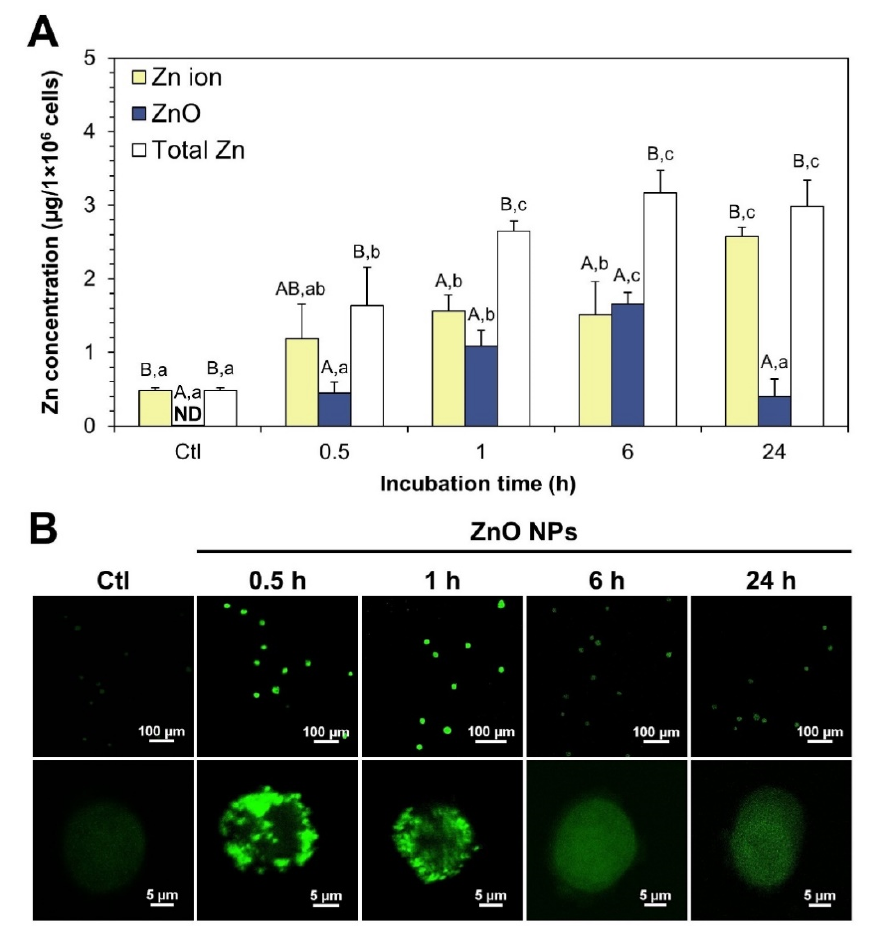
Figure 6. ( A ) Intracellular fate of ZnO NPs in human intestinal Caco-2 cells, as determined by CPE followed by ICP-AES analysis. ( B ) Confocal microscopic images of intracellular Zn ions, as determined by a Zn-selective fluorescent probe, TSQ in Caco-2 cells. Different upper-case letters (A,B) indicate significant differences among Zn ion, ZnO, and total Zn ( p < 0.05). Different lower-case